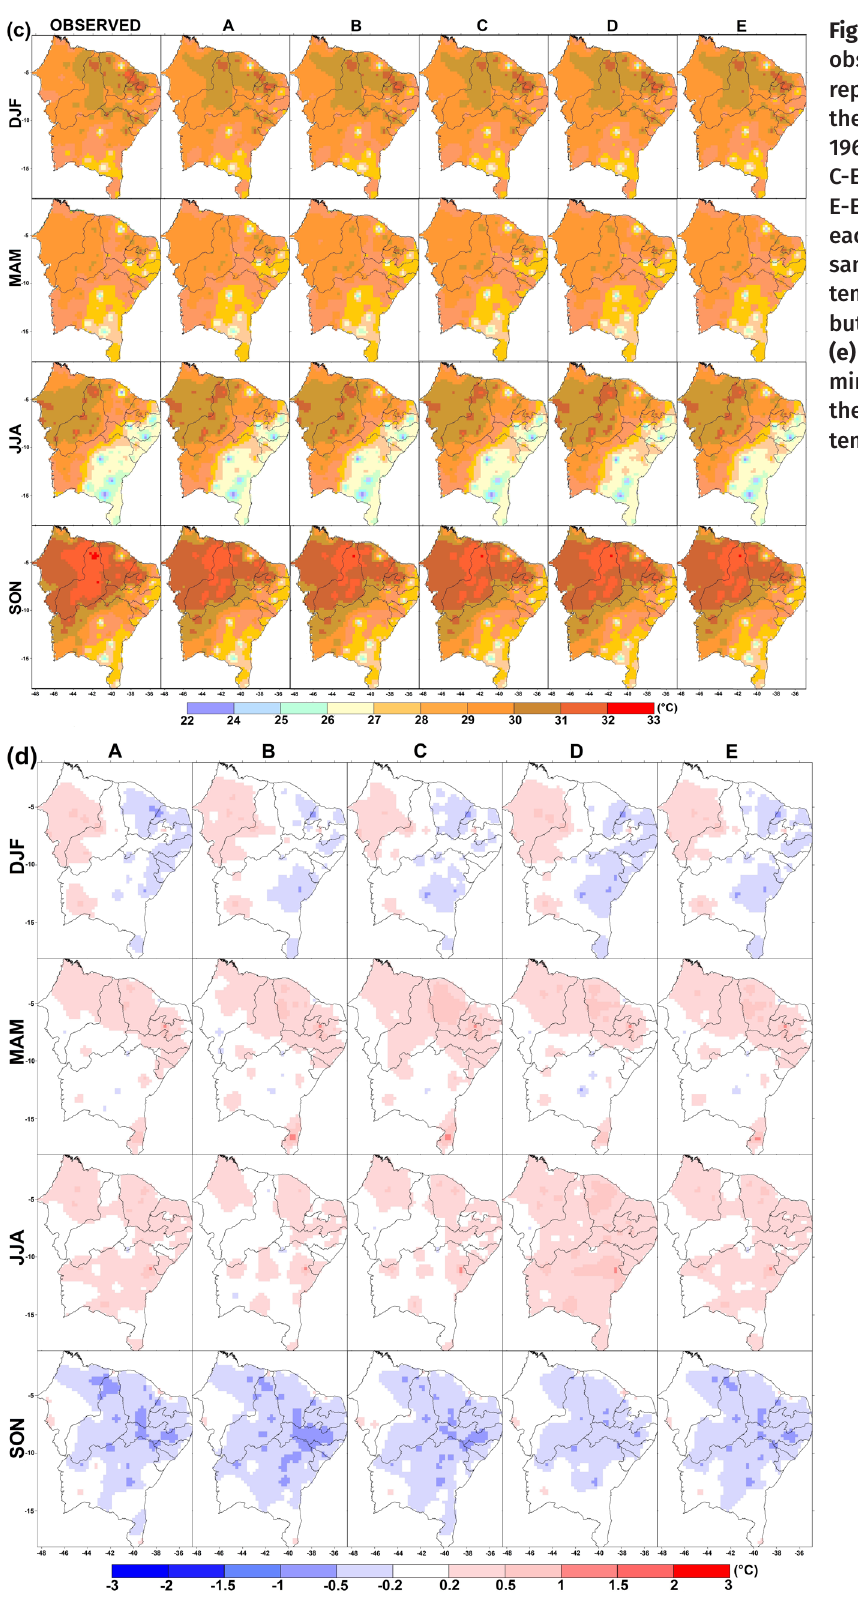
Figure 3. (a) Seasonal means of observed rainfall and the ones reproduced by each model and the ensemble for the period 1961-1990 (A-BCM2, B-CNRMCM3, C-ECHAM5-OM, D-HadGEM2-ES, E-ENSEMBLE), (b) deviations of each model for rainfall, (c) the same as a, but for maximum temperatures, (d) the same as b, but for maximum temperatures, (e) the same as a, but for minimum temperatures and (f) the same as b, but for minimum